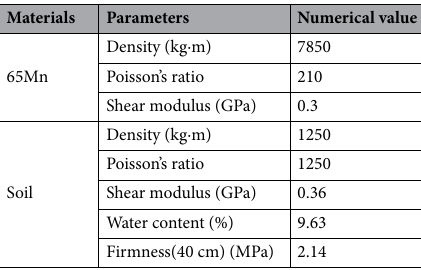
Table 1. Soil and rotary tiller material parameters.